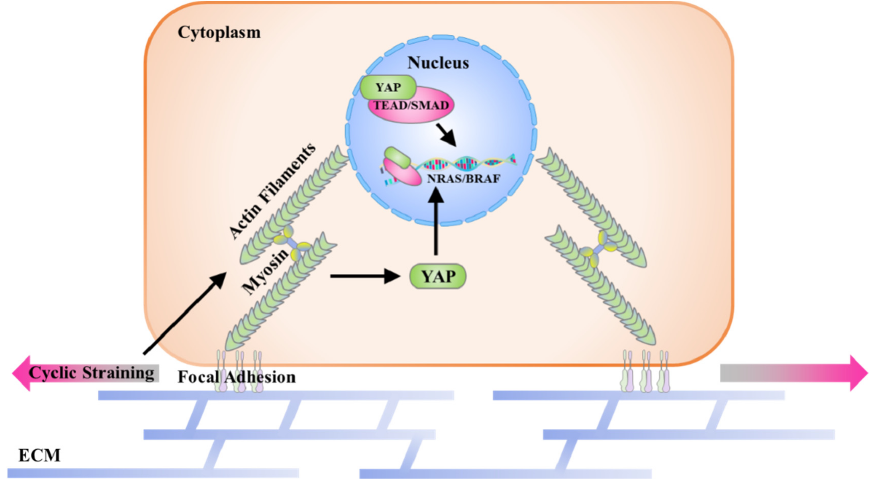
Figure 8. Schematic representation of the potential mechanism in cyclic-straining-promoted proliferation through regulatory morphogenesis. Supplementary Materials: Supplementary materials can be found at www.mdpi.com/arti- cle/10.3390/ijms231911884/s1.